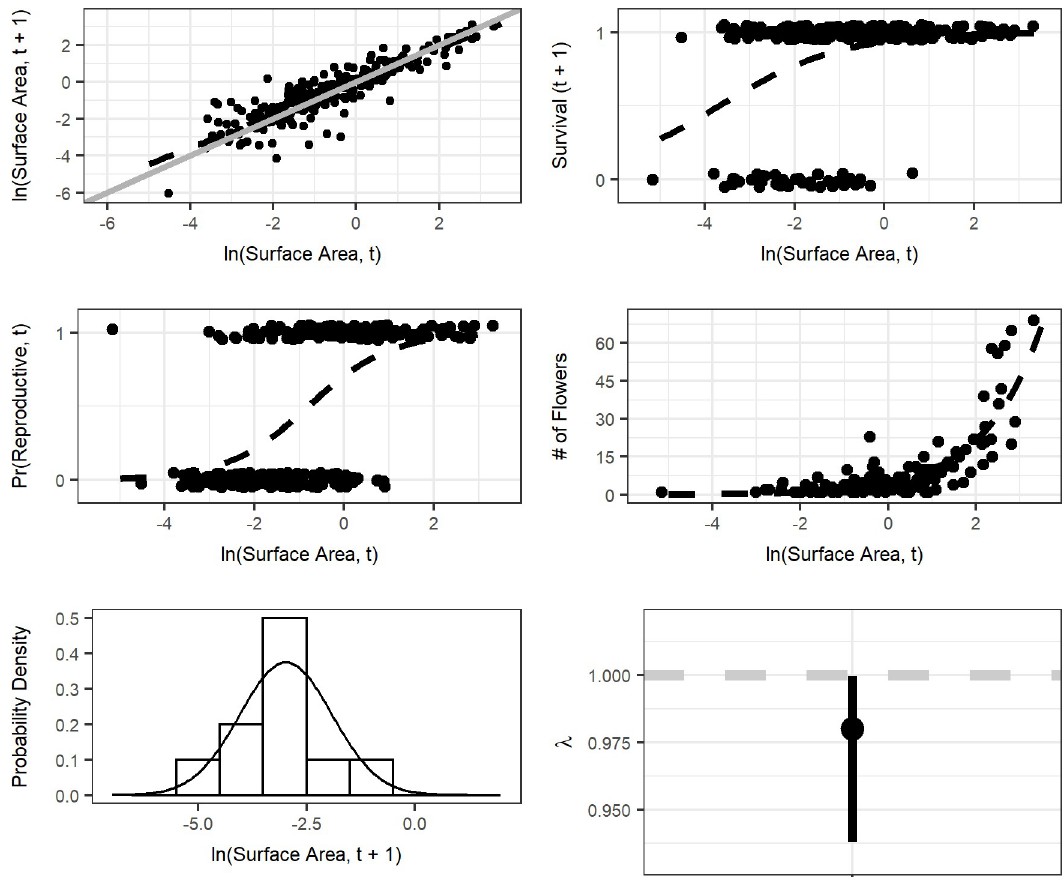
Fig 3. Vital rates models. Results for ramet growth (a), survival (b), probability of flowering (c), flower production (d), and recruit size distribution (e), and per-capita population growth rate with 95% bootstrap confidence intervals (f). The dotted black lines in a-c, e and the solid black line in d are fitted relationships from the models described in Methods. In (a), the solid grey lines show a 1:1 relationship (i.e. no change in ramet size), and the dotted grey line in f denotes a per-capita population growth rate of 1 (e.g. population level